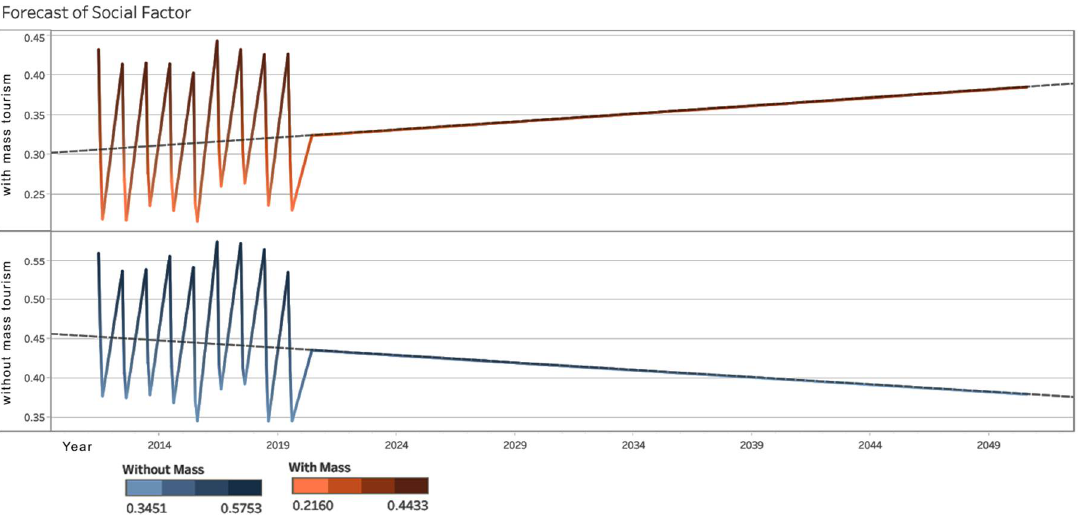
Figure 14. Forecast of the social factor until 2050.